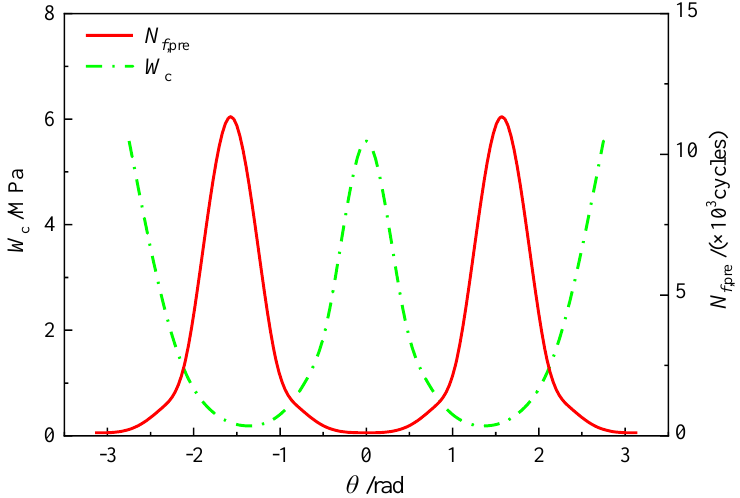
Figure 11. The first principal elongation distribution of the flexible joint elastomers.